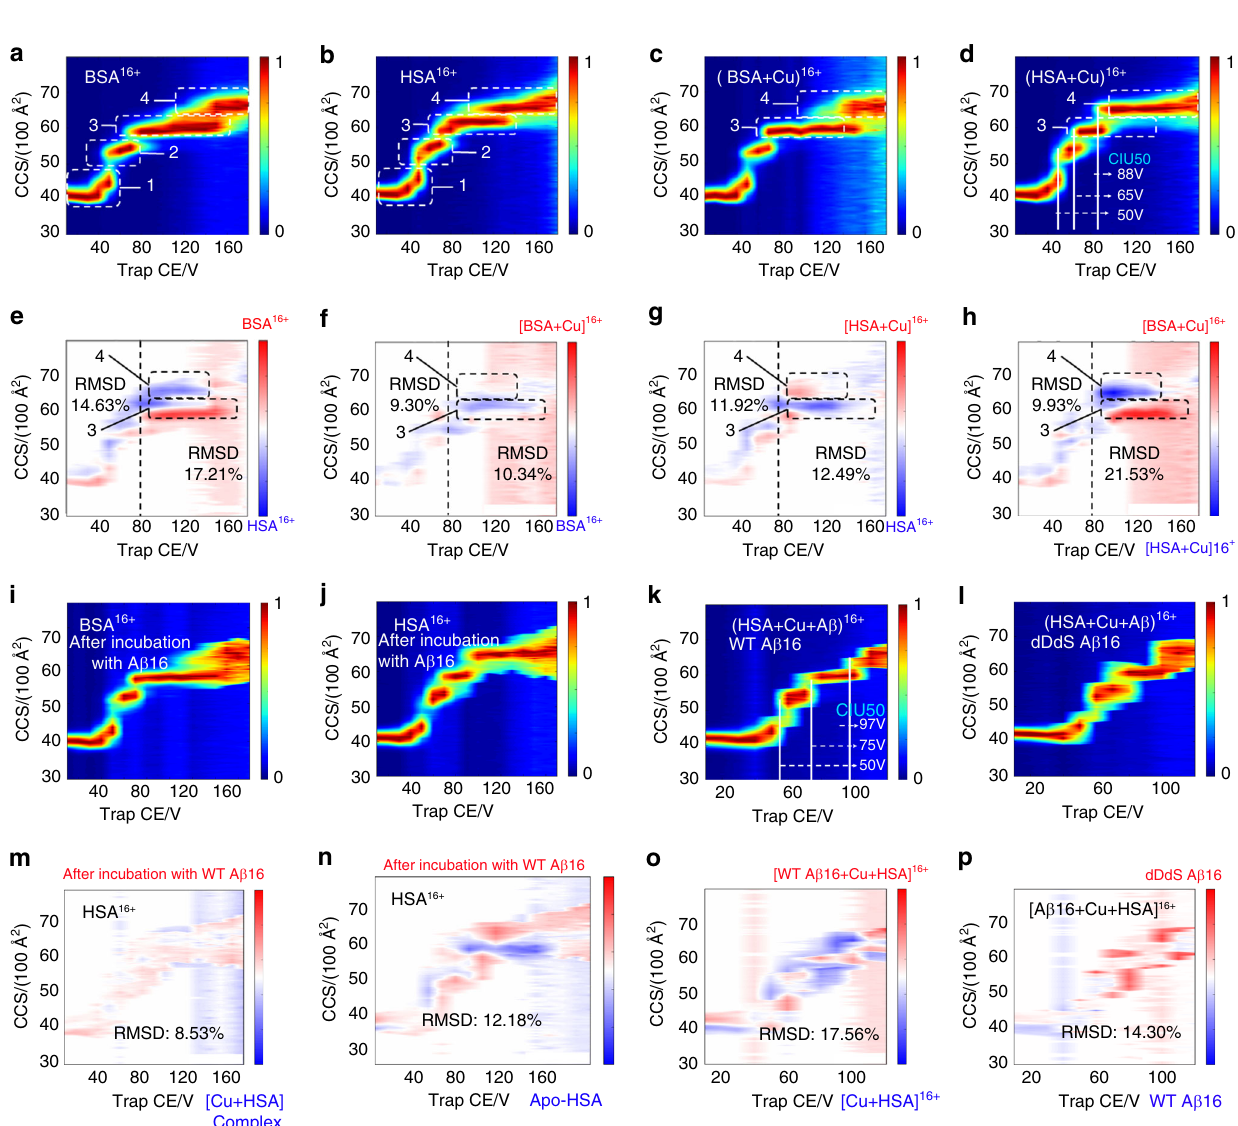
Fig. 5 iCAP for distinguishing chiral A β (1 – 16) recognition of receptors. CIU fi ngerprints: 16 + apo-serum albumin ( a , b ), metal-bound serum albumin ( c , d ), remaining serum albumin after incubation with A β (1 – 16) and Cu ( i , j ), and triple HSA-A β -Cu complex ( k , l ). CIU difference plots: between BSA and HSA ( e / h ), between BSA-Cu complex and BSA ( f ), between HSA-Cu complex and HSA ( g ). The structural changes induced by A β (1 – 16) binding were indicated by CIU50 ( d / k ) and CIU difference plots of HSA ( m / n ) and HSA-Cu complex ( o ). The differences between WT and dDdS A β (1 – 16) were presented by CIU difference plots of HSA-A β -Cu complex ( p ). Four major conformer families (1 − 4, highlighted in a – d ) are detected. Buffer, 100 mM NH 4 OAc. Concentrations: A β (1 – 16), 15 µ M; Cu 2 + , 20 µ M; BSA/HSA, 7.5 µ M. Source data are provided as a Source Data fi le